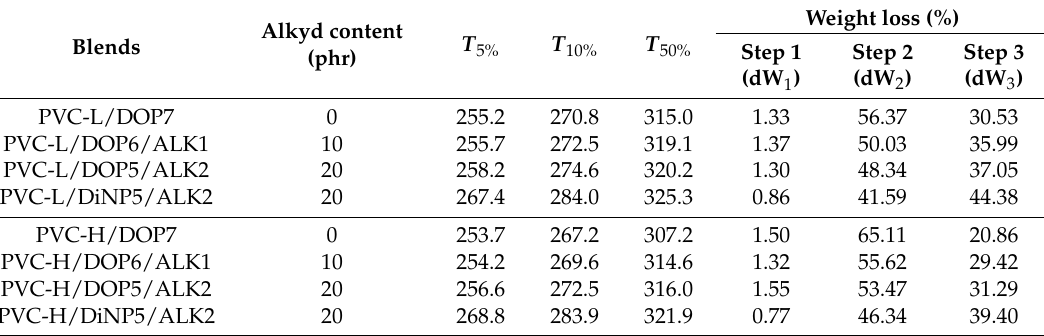
Figure 7. Thermogravimetric thermograms of varying proportions of palm oil-based alkyd in ( a ) PVC-L blends and ( b ) PVC-H blends. Table 2. Thermogravimetric (TGA) results for PVC plasticized sample with different proportions of palm oil-based alkyd. d W 1 = wt loss from 35 to 230 °C, d W 2 = wt loss from 230 to 320 °C, d W 3 = wt loss from 320 to 520 °C.